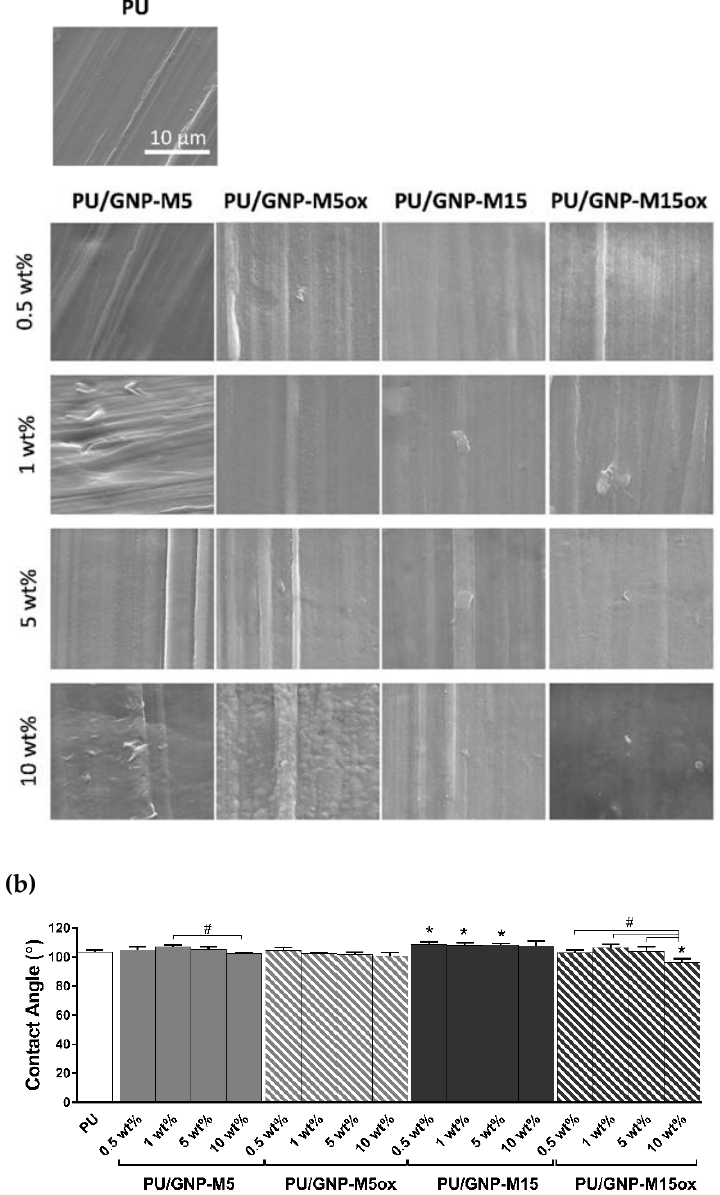
Figure 3. Characterization of polyurethane (PU)/GNP composites: ( a ) surface topography and ( b ) wettability of PU and PU/GNP composites with different GNP content produced by melt ‐ blending. Images were obtained by SEM (scale bar = 10 μ m) and wettability determined by water optical contact angle measurements. * and # statistically significantly different from control (PU) and differences between samples, respectively (one ‐ way ANOVA; p ≤ 0.05).